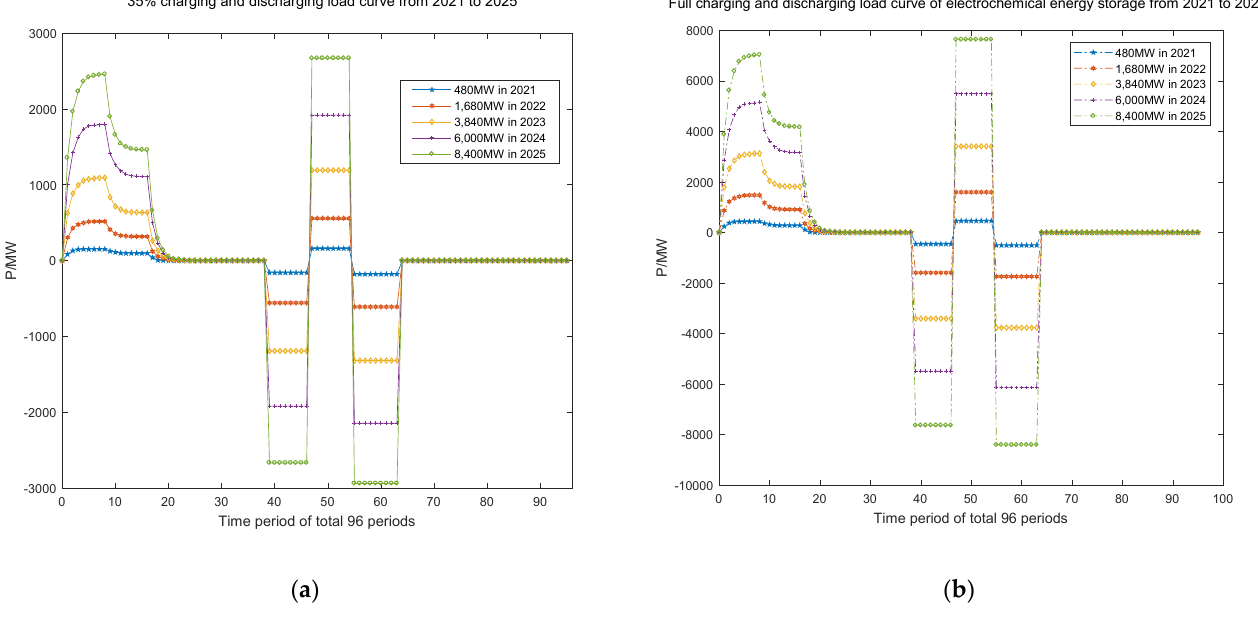
Figure 8. The charging and discharging load curves of the planned capacity of electrochemically stored energy from 2021 to 2025: ( a ) 35% charging and discharging; ( b ) full charging and discharging.